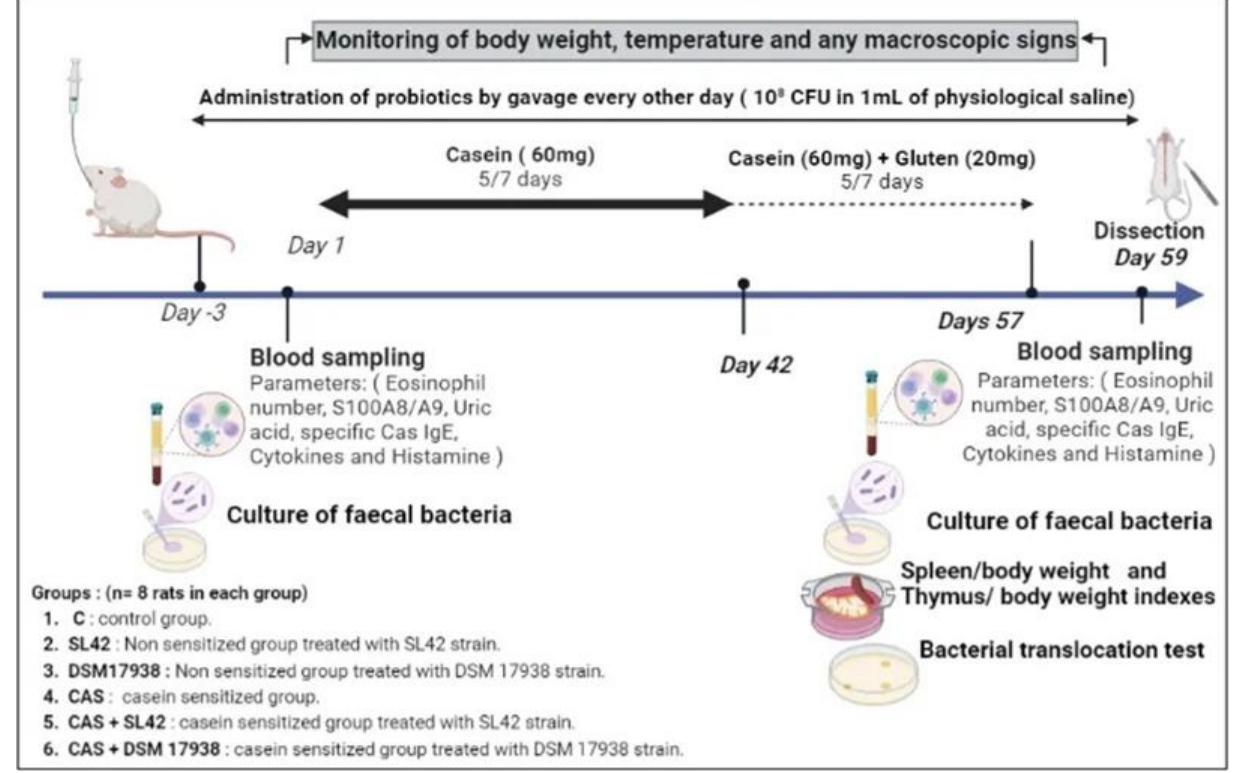
Figure 1. Experimental design of the present study. Bovine casein (Protifar©) was taken as allergen and was administered intragastrically to rats without the use of adjuvant. A total of 48 female rats (3 weeks old) were randomly divided into 6 groups (n = 8 rats per group): control group receiving only PBS (C group), nonsensitized group treated with SL42 strain (SL42 group), nonsensitized group treated with DSM 17938 strain (DSM 1938 group), casein-sensitized group (CAS group), casein-sensitized group treated with SL42 (CAS + SL42 group), and casein-sensitized group treated with DSM 19738 strain (CAS- + DSM 19738 group). In all probiotic-treated groups, SL42 or DSM 17938 were given every other day from day − 3 to day 58.